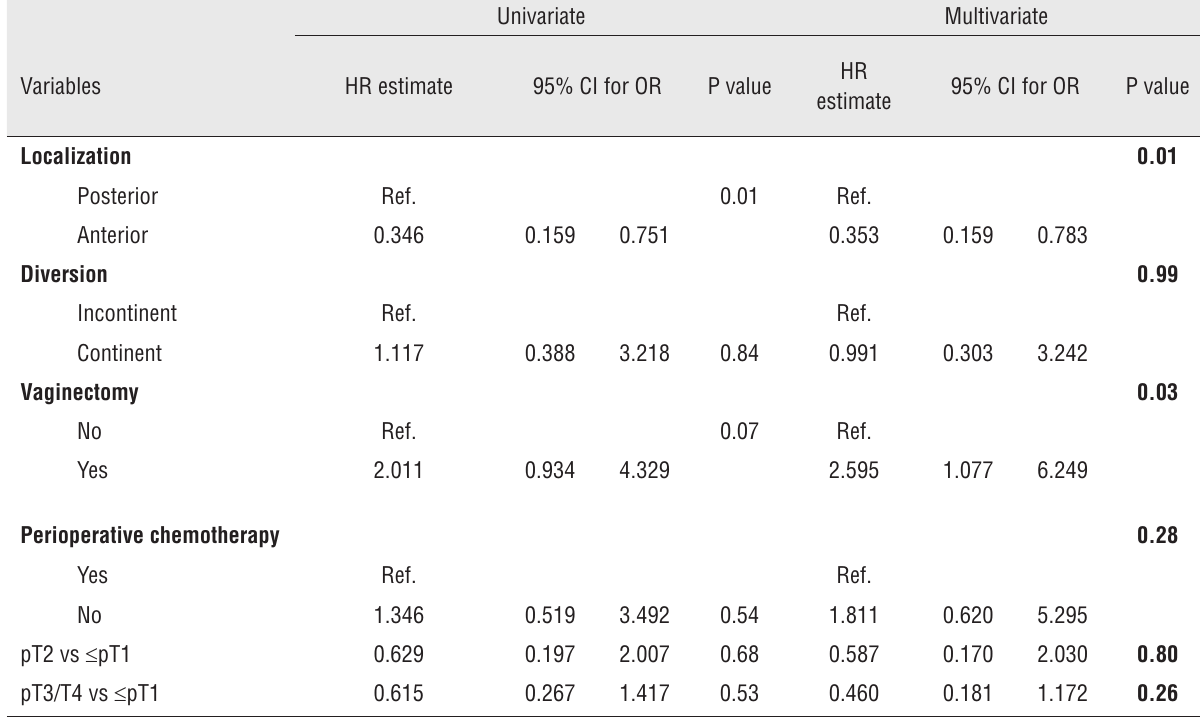
Table 3 - Multivariate Association of Risk factors with vaginal cuff Recurrence vs Recurrence at Other Site. Univariate Multivariate HR Variables HR estimate 95% CI for OR P value Localization